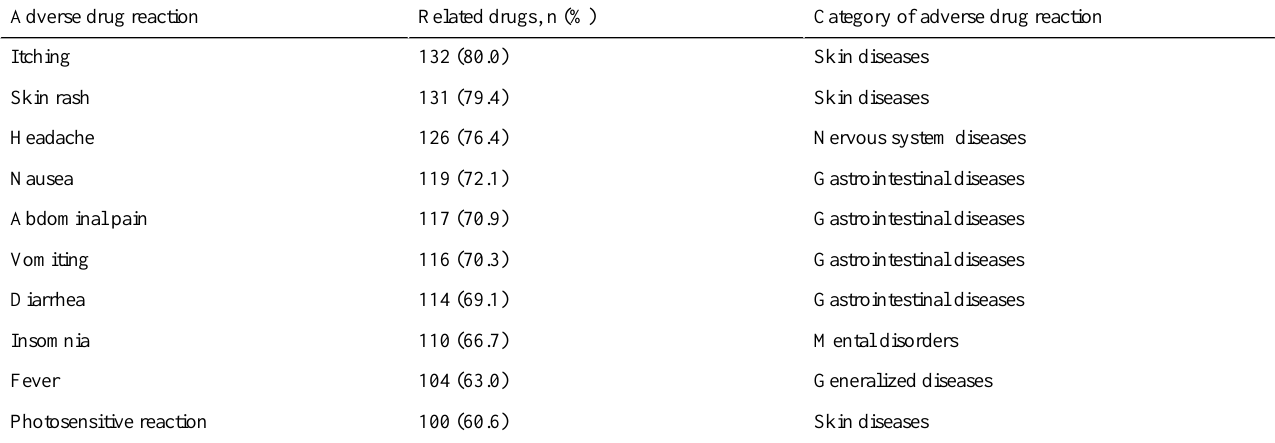
Table 4. The 10 most commonly reported adverse drug reactions of quinolones